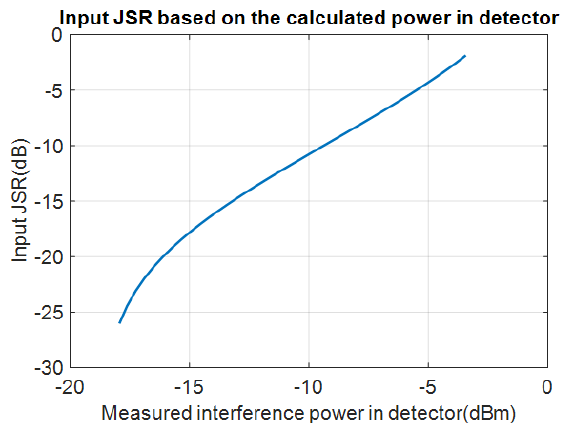
Figure 11. Input JSR estimation based on the measured interference power in detector.